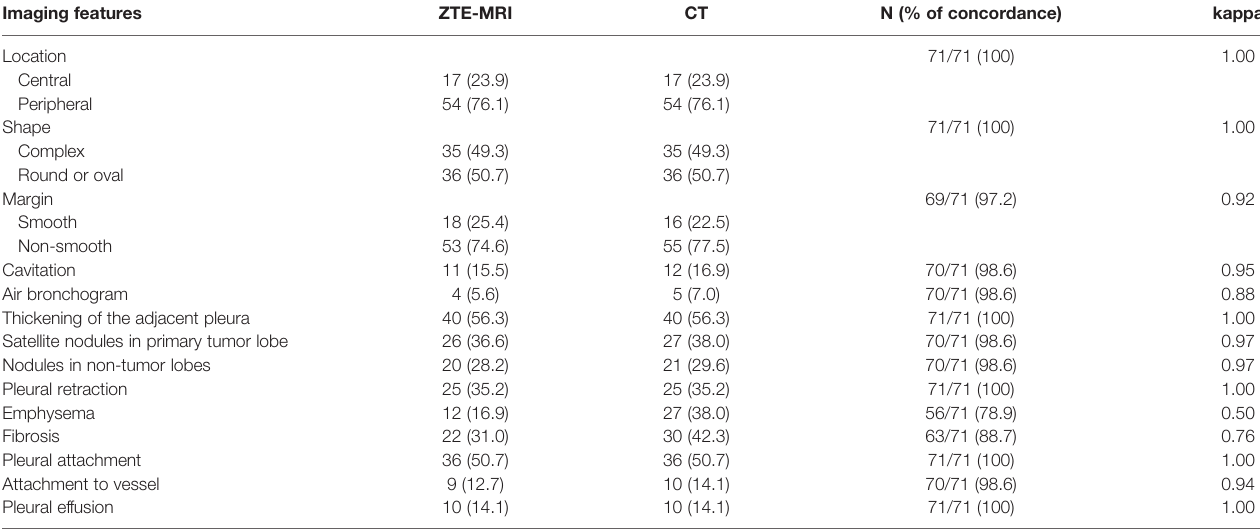
TABLE 2 | Inter-modality agreement for imaging features between ZTE-MRI and CT. Imaging